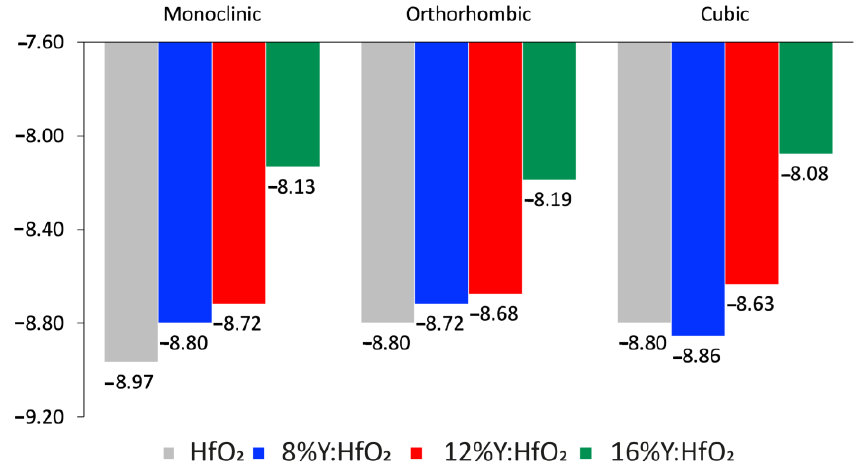
Figure 2. Ground state cohesive energy formation. Monoclinic P2 1 /c, orthorhombic Pca2 1 , and cubic Fm 3̅ m polymorphs of HfO 2 (grey bar), 8% Y:HfO 2 (blue bar), 12% Y:HfO 2 (red bar), and 16% Y:HfO 2 (green bar).